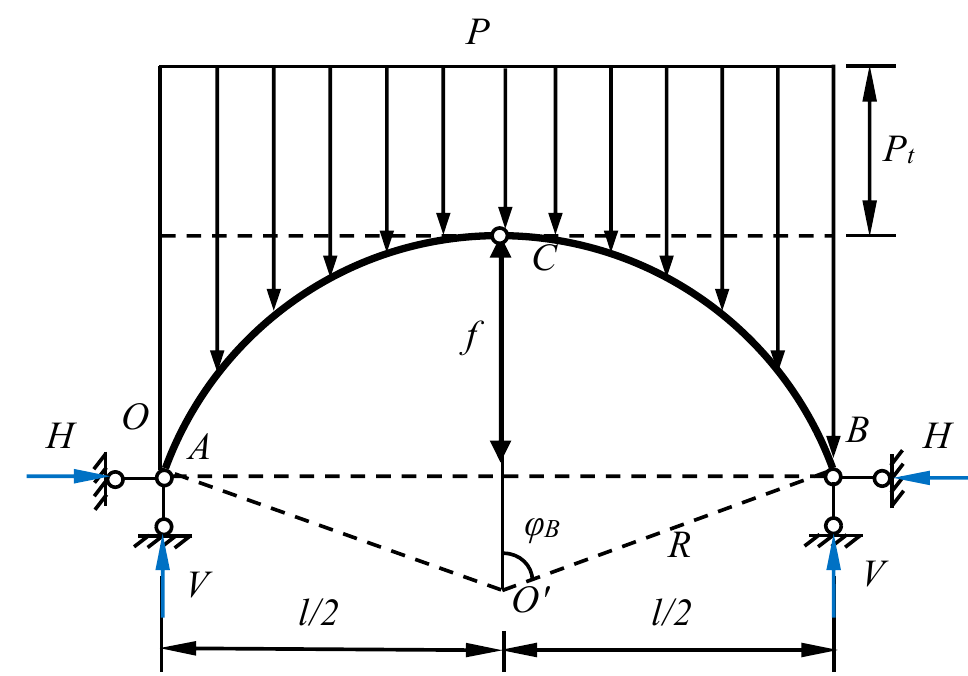
Figure 7. Three-hinged arch calculation model of arch